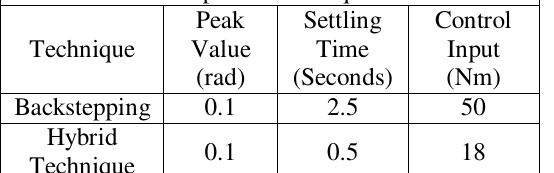
Table 2: Comparisons between Backstepping and Proposed